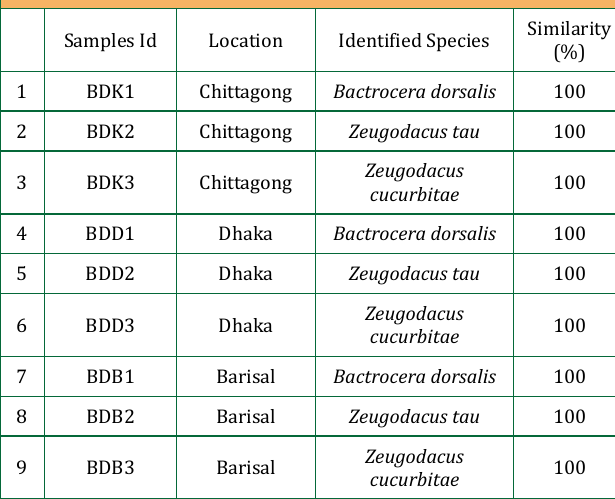
Table 4: Identified adult fruit fly species from different location of Bangladesh Samples Id